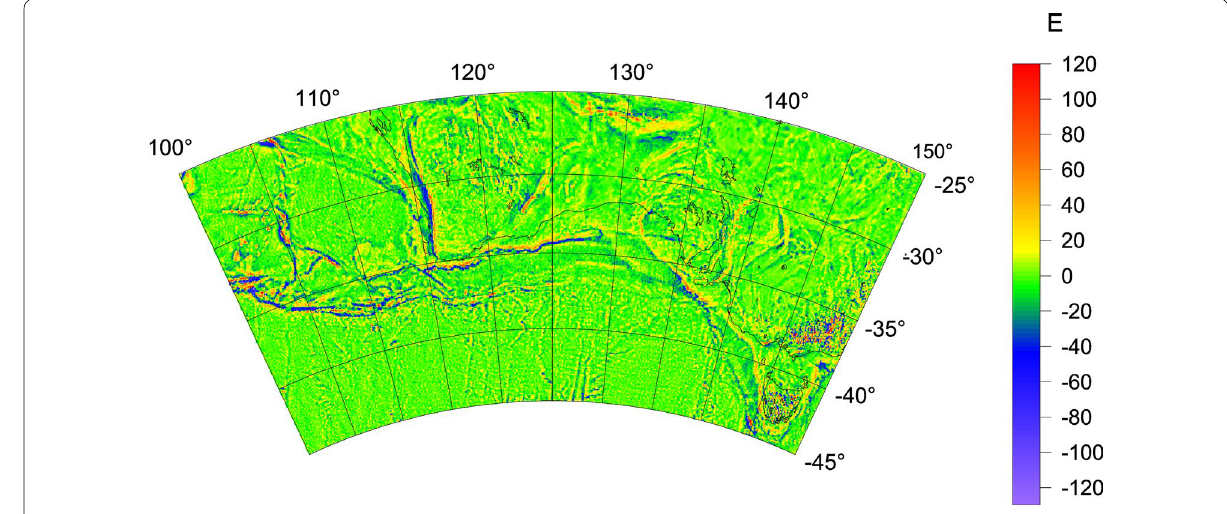
Fig. 15 T zz [E] for southern Australia with EIGEN 6C4